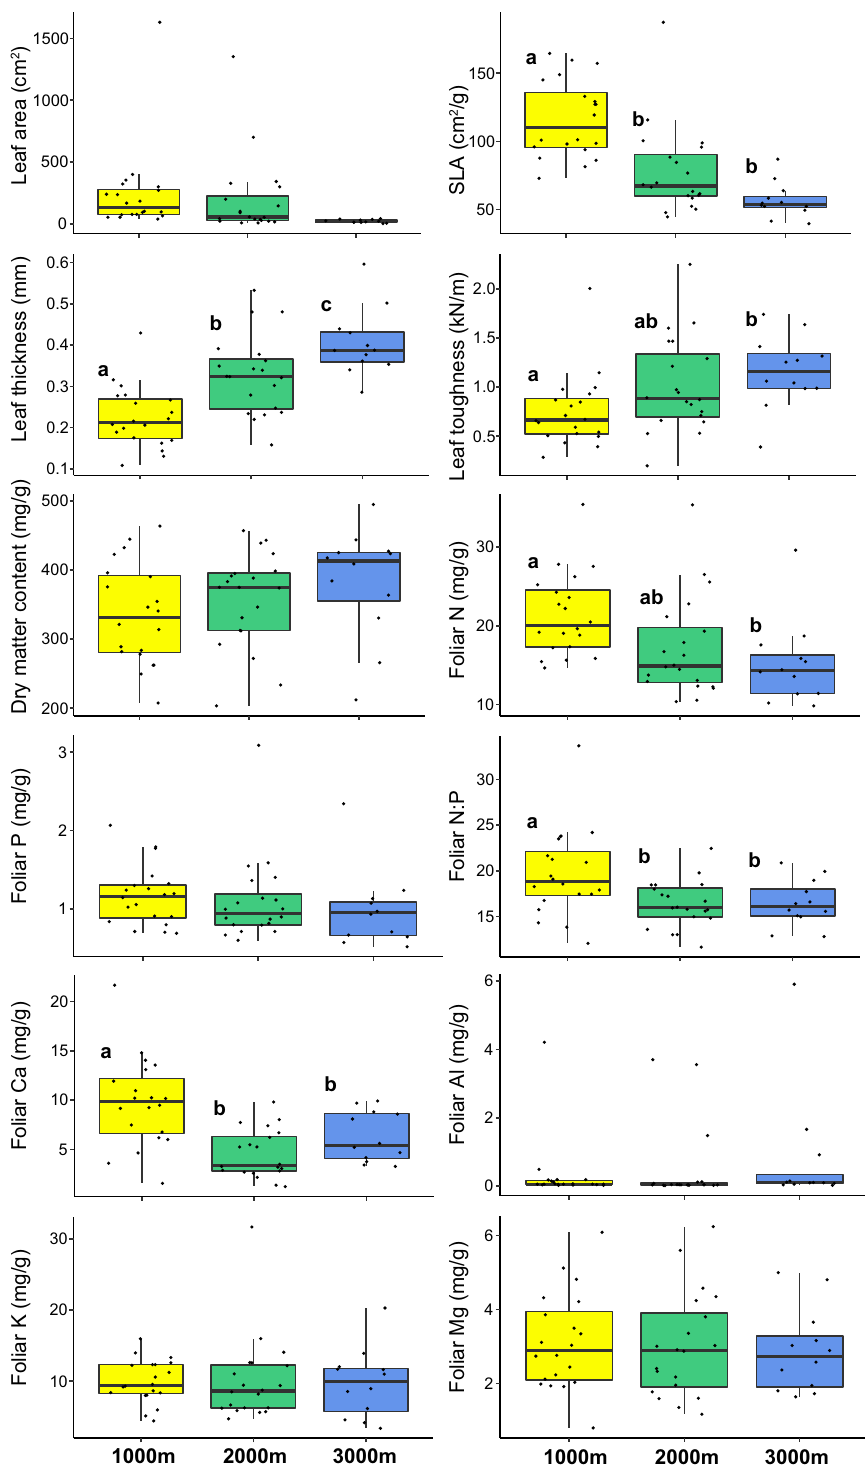
Figure 1. Boxplots showing the leaf trait distribution of the studied tree species at the three elevations. Different letters represent significant differences between study sites (Tukeys